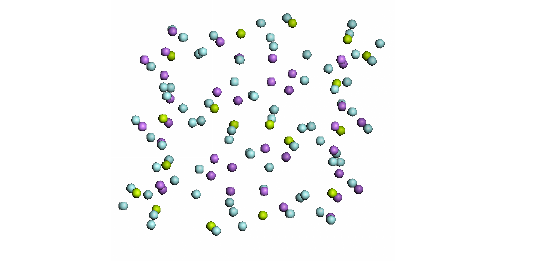
Fig. 2. Supercell of LiF-BeF 2 system (288 LiF molecules and 144 BeF 2 molecules)